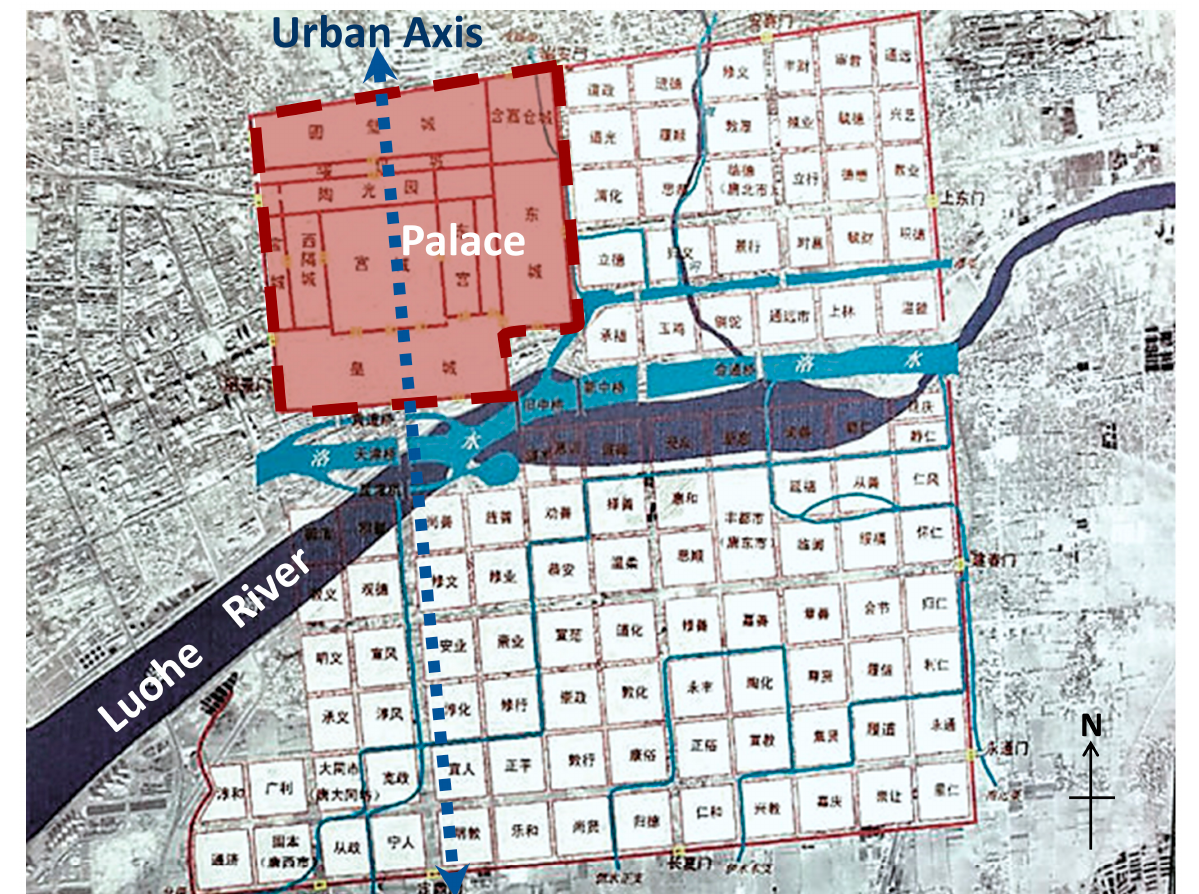
Figure 2. Restoration of the capital city of Luoyang in the Sui Dynasty. (Map retrieved from the book The History of Chinese Architecture.